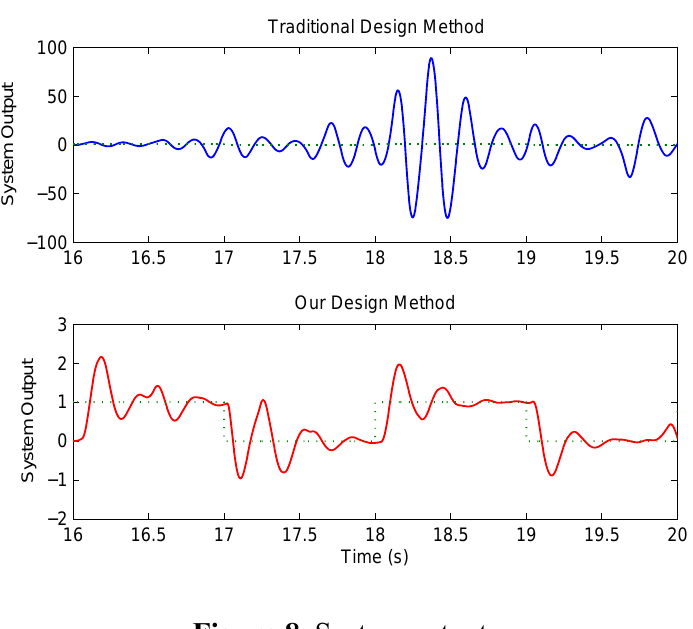
Figure 8. System